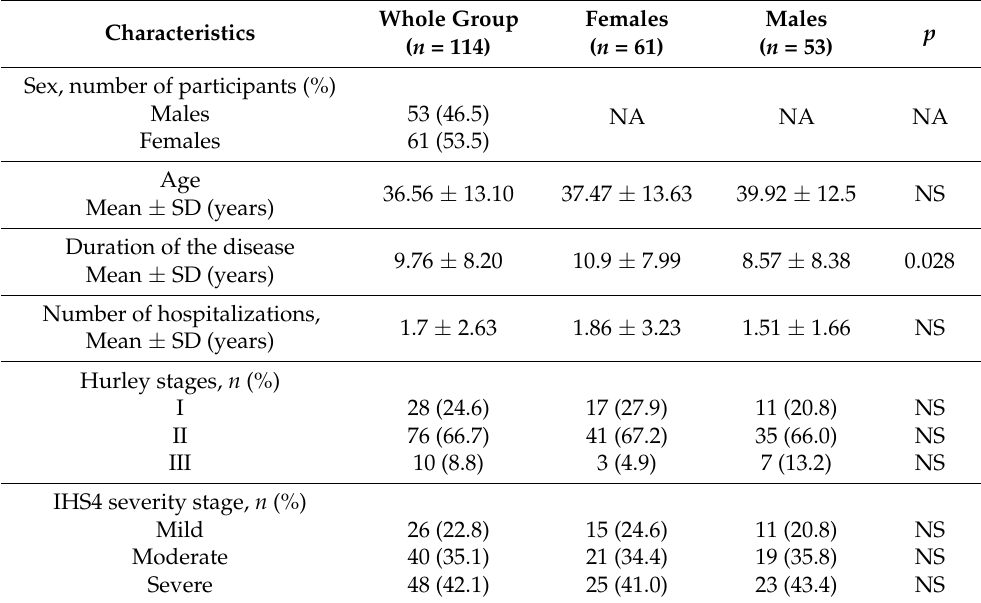
Table 1. Demographic and clinical characteristics of HS